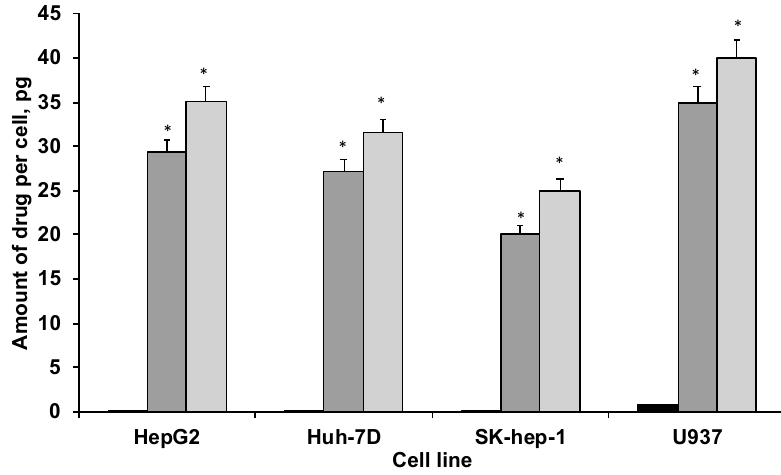
Figure 5. Cellular uptake of PTX in HepG2, Huh-7D12, SK-hep-1 and U937 cells after 4 h exposure to drug alone and in formulation ( n = 3, ±SD). PTX, PAA-Ox5+PTX, PAA-Ox5-HNPc+PTX. * denotes significance compared with free drug, p < 0.001.